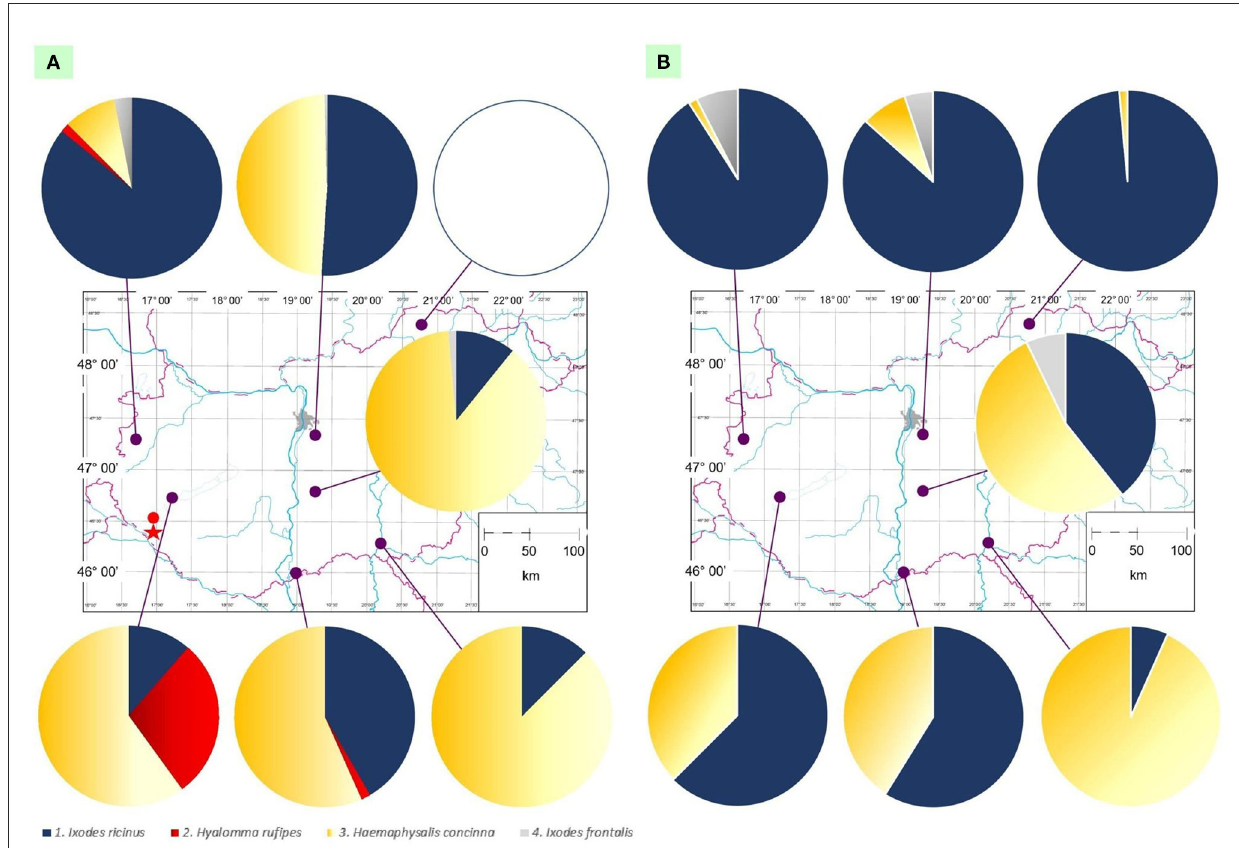
FIGURE1 Map of Hungary showing ringing stations and the ratio of tick species collected in (A) the first semiannual period (March to July) and (B) the second semiannual period (August to November). In the former (A) the location of the first Hyalomma nymph reported from a bird in Hungary in 1955 is marked with a red dot, and the place where adult Hyalomma rufipes ticks were found on cattle is indicated with a red star.